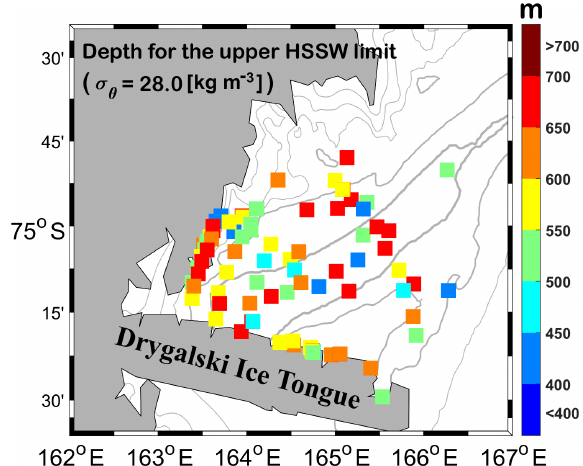
Figure 10. Distributions of depth (m) for the upper HSSW limit ( σ θ = 28kgm − 3 ) in vertical CTD profiles during the four hydro- graphic surveys (see details in Table 1). The bold gray line indicates the 1000m isobaths and the interval between the thinner gray lines is